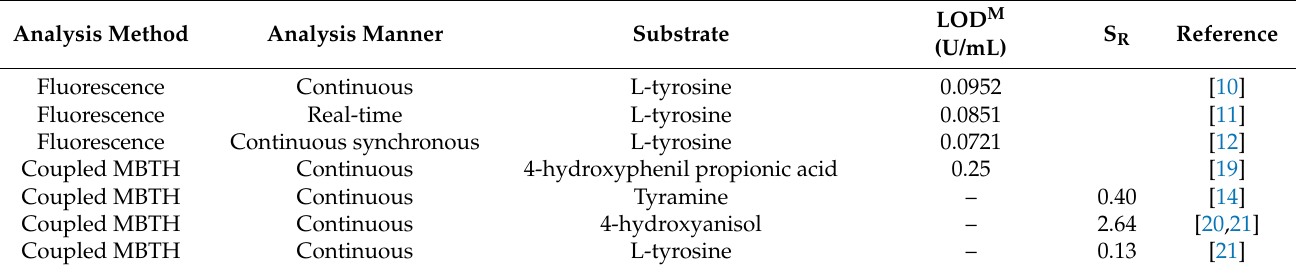
Table 1. Comparison of different methods to determine monophenolase activity in mushroom tyrosinase. Analysis